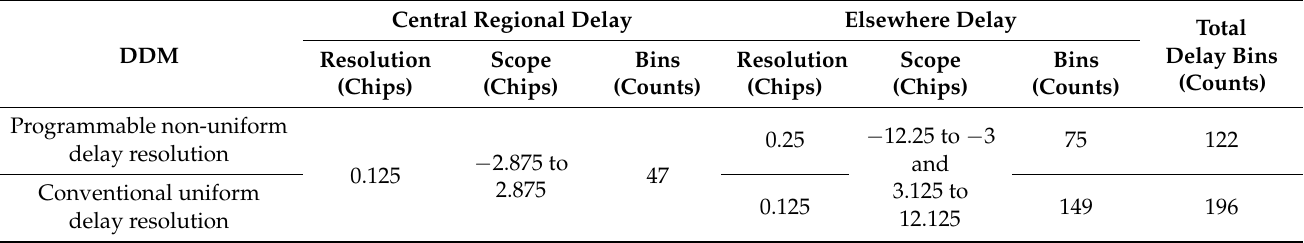
Table 2. Based on a typical DDM delay scope of -12.25 – 12.125 chips, the comparison of number of delay bins between DDM with non-uniform delay resolution and conventional DDM with uni- form delay resolution is shown.